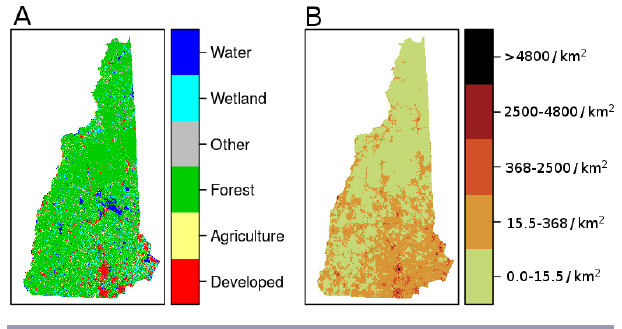
Fig. 1. New Hampshire land cover in 2011 (A) and population density in 2010 (B). Sources: (A) Rubin and Justice ( unpublished data ), enhancing NOAA (2014); (B) U.S. Census Bureau